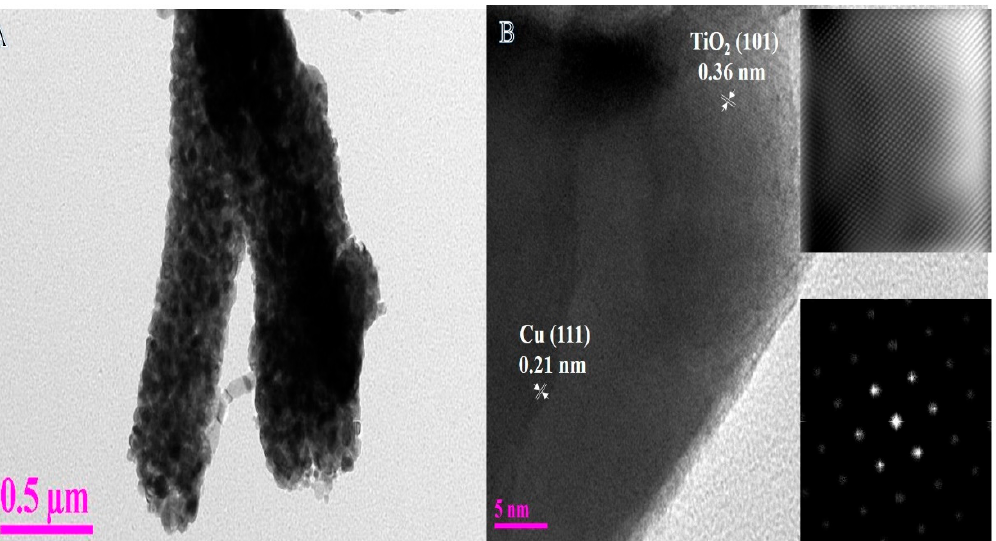
Figure 2. ( A ) Normal TEM image and ( B ) HR-TEM image of produced powder after the hydrothermal process (Inset in b shows the SAED image).